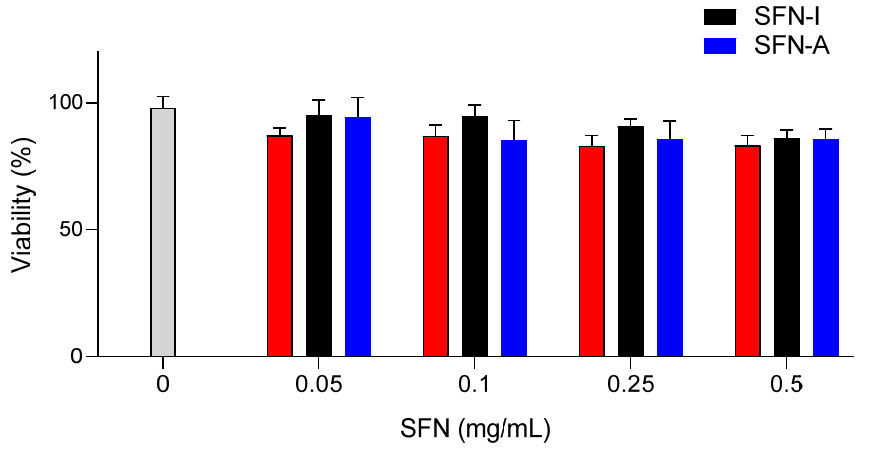
Figure 5. Cytotoxic effect of the non-sterilized (SFN-C, in red) or sterilized nanoparticles (SFN-I, in black and SFN-A, in blue) on murine fibroblast viability compared with the viability of L929 cells in absence of nanoparticles as control (100%). Data are expressed as percentage of cell viability ± SD vs. concentration. At least four samples per condition were measured.